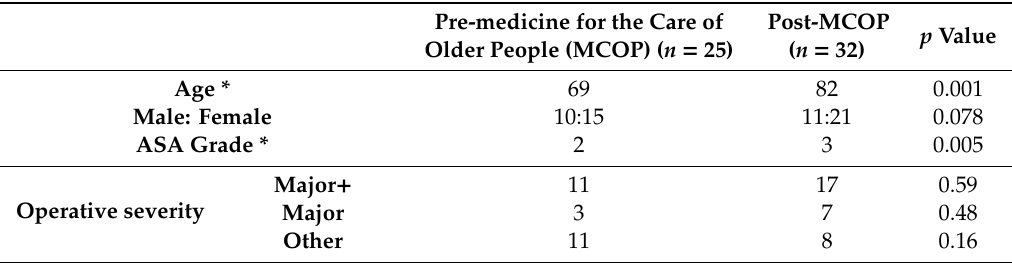
Table 1. Peri-operative characteristics and demographics.